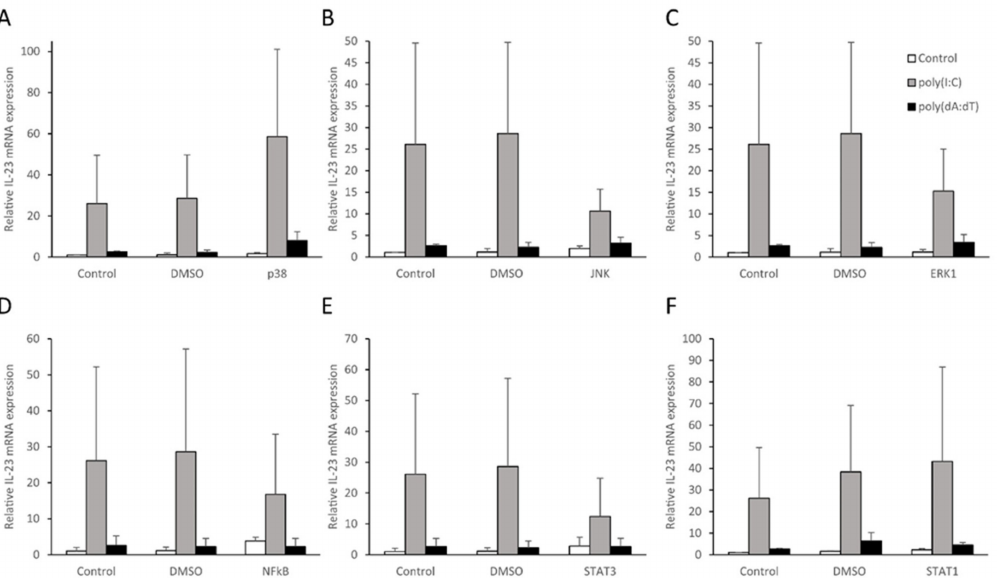
Figure 5. Inhibition of the JNK, ERK1, NF- κ B and STAT3 pathway components had an effect on the nucleic-acid-induced IL-23 mRNA expression of NHEK cells ( A – F ). Specific inhibiton of signaling pathway components was used for 1 h with the cells being subsequently transfected with 0.666 µ g/mL poly(I:C) and 1 µ g/mL poly(dA:dT) for 24 h. Equal concentration of DMSO was used as solvent control for each inhibitor, demonstrating no difference from non-pretreated control samples. Relative expression was determined by the ∆∆ Ct method, normalized to GAPDH mRNA expression and compared to the expression of the untreated control samples. Data are presented as mean of three independent experiments ± SD. Significance was tested by one-tailed, paired T -test comparing to DMSO-treated solvent-control samples. In spite of obvious differencies in the values, no significance could be demonstrated among them due to high standard deviations of the independent experiments performed on NHEKs derived from independent